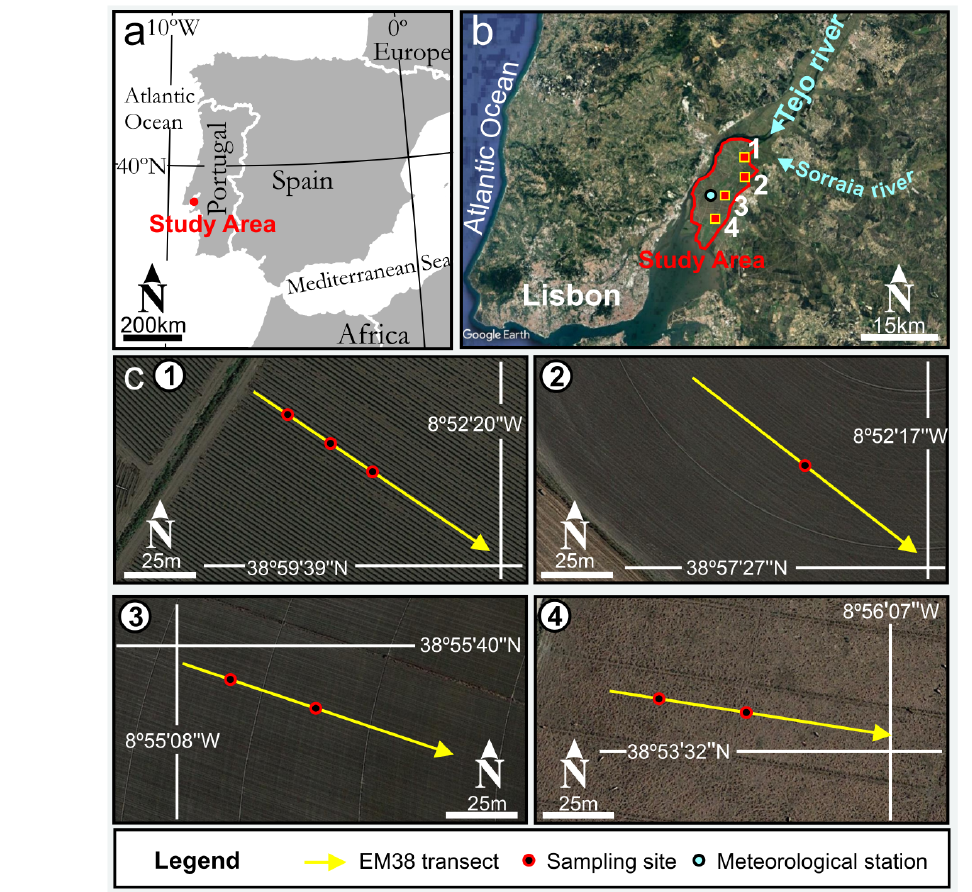
Figure 1. (a–b) Location of the study area in Portugal, showing the main geographical features and the four locations; (c) details of the four locations showing the EM38 transects and the soil sampling sites © Google Earth.